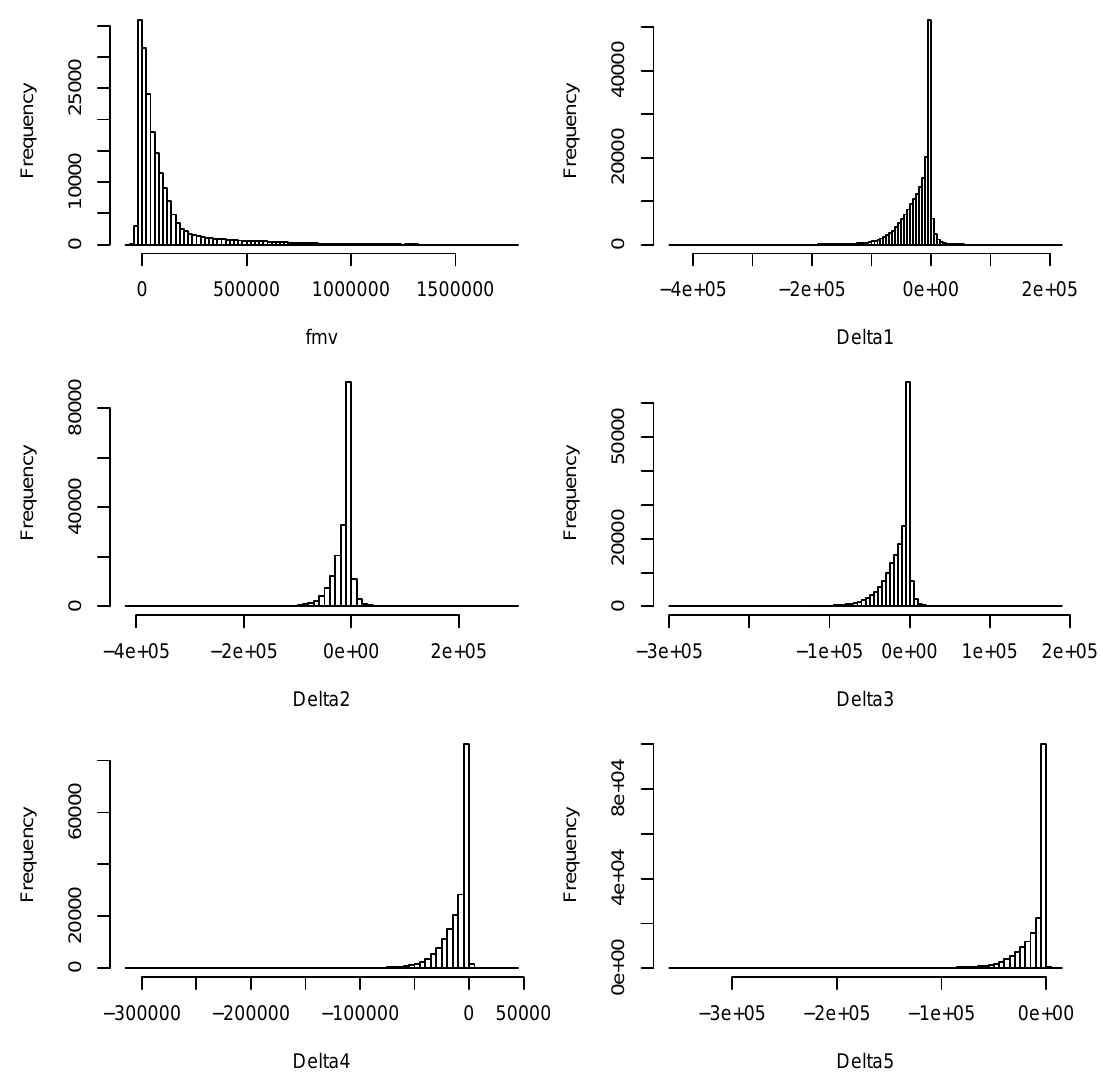
Figure 2: Histogram of the fair market values and the deltas of individual